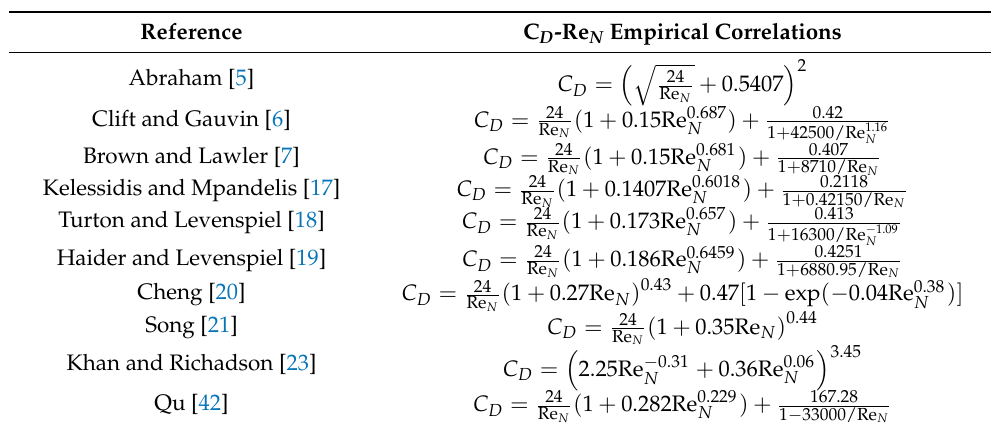
Figure 7. Relationship between spherical particle sedimentation experiment and predicted C D -Re N . Table 3. C D -Re N correlation of spherical particles settling in NF and NNF proposed by predecessors.